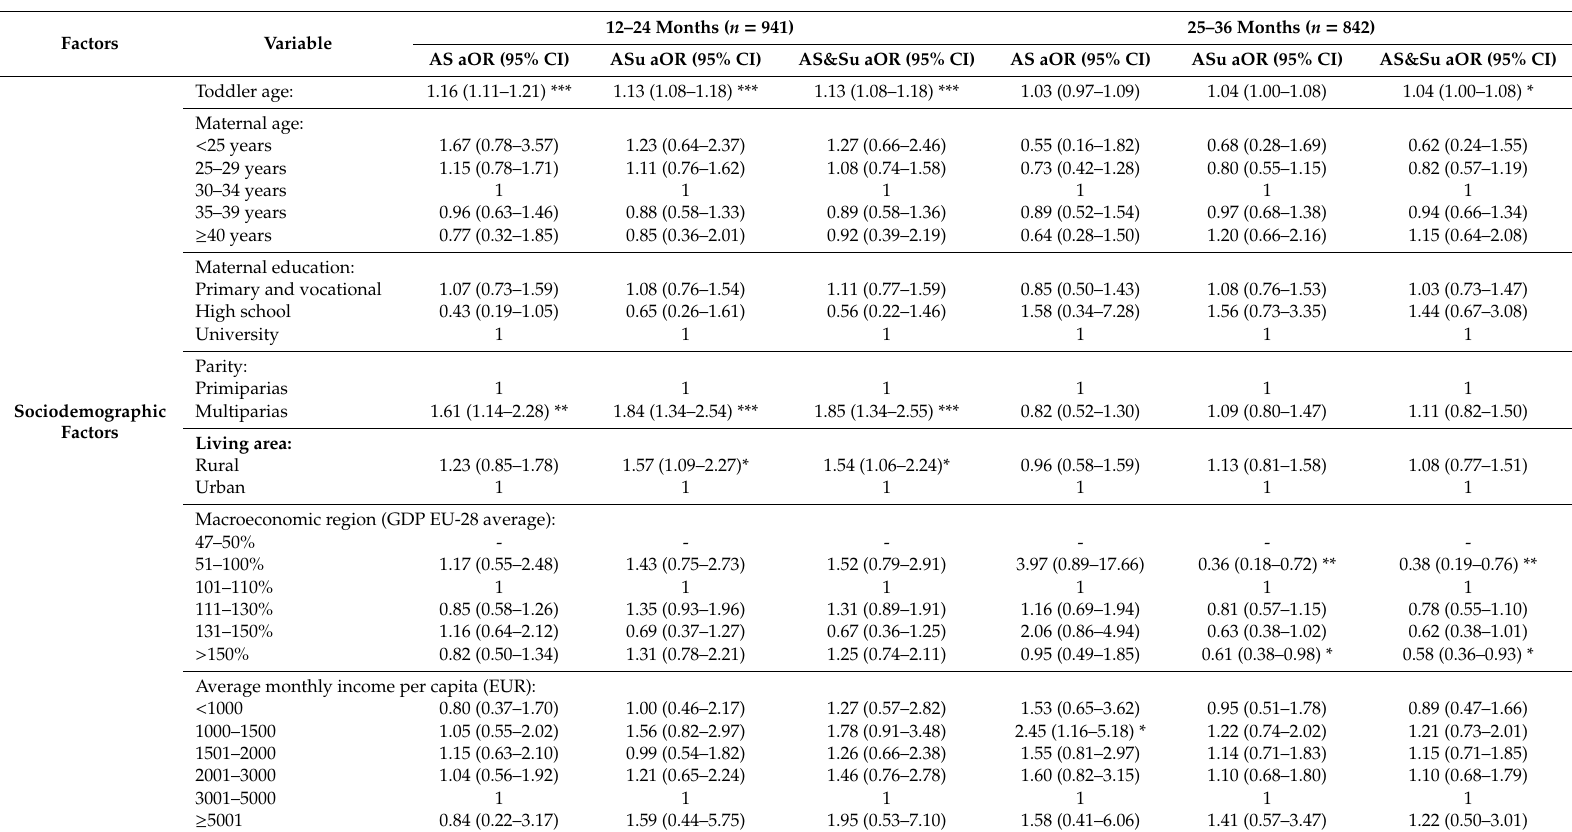
Table 3. Multivariate regression analysis models of factors influencing the use of added salt, sugar, and salt and sugar in the Austrian toddlers ( n = 1783).